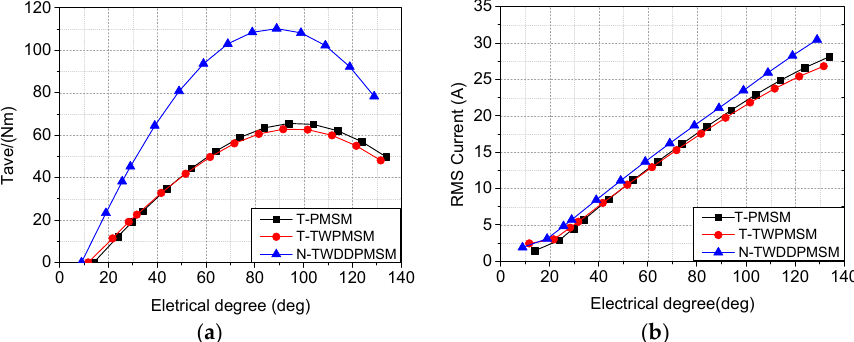
Figure 11. Waveforms of torques and RMS currents of three motors: ( a ) torque-angle waveforms; ( b ) RMS current-angle waveforms.